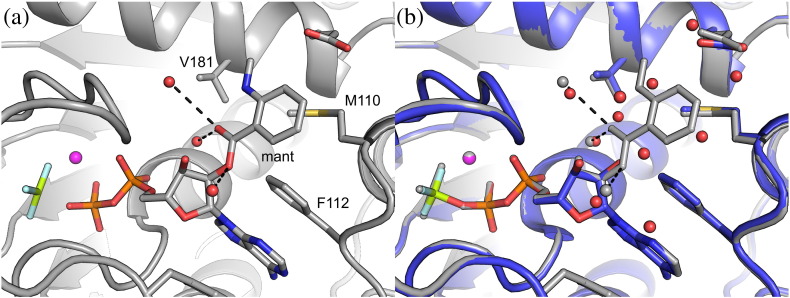
Interactions between mant-ADP·BeF3 and Dbp5. (a) The mant fluorophore buries adjacent residues (Val181, M110, and Phe112) of ∆90Dbp5 via hydrophobic interactions (< 4.0 Å). The mant moiety hydrogen bonds (broken lines) with waters at the solvent-exposed surface. (b) Displacement of a network of hydrogen-bonded water molecules by the mant fluorophore. ∆90Dbp5-ADP·BeF3 (blue) and the associated water molecules (red) of 3PEY superimposed to ∆90Dbp5-mant-ADP·BeF3 and the associated water molecules (gray). π Stacking of the adenine is maintained. rmsd = 0.1106 Å.